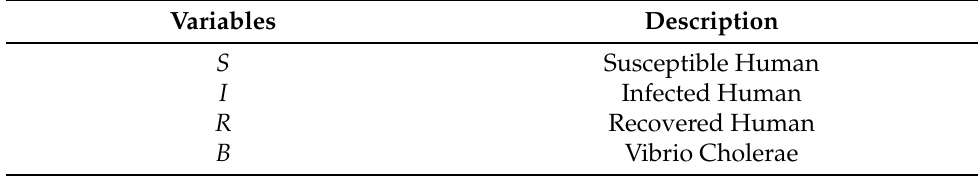
Table 1. Table showing the variables in the model.